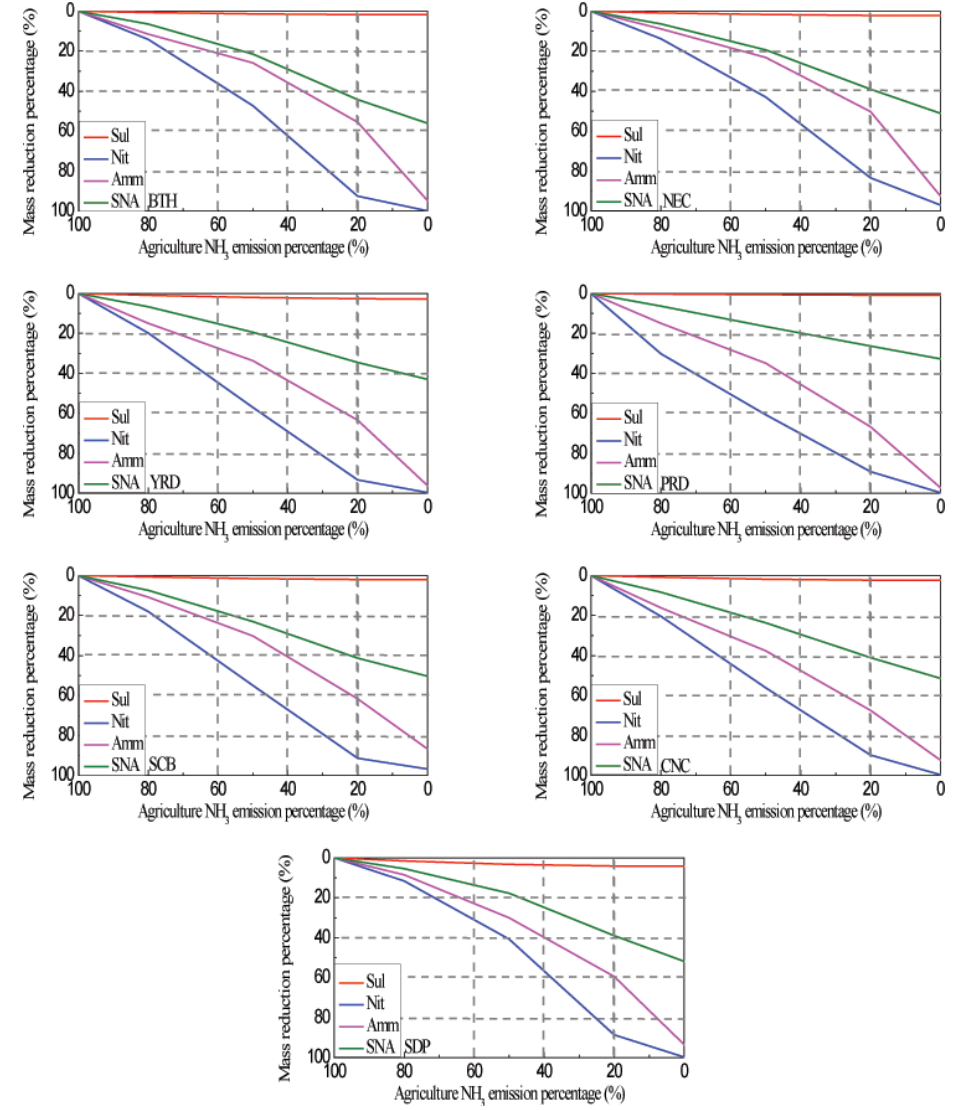
Figure 8. The variation (%) of sulfate, nitrate, ammonium, and SNA mass burden associated with the NH 3 emission reduction (%).